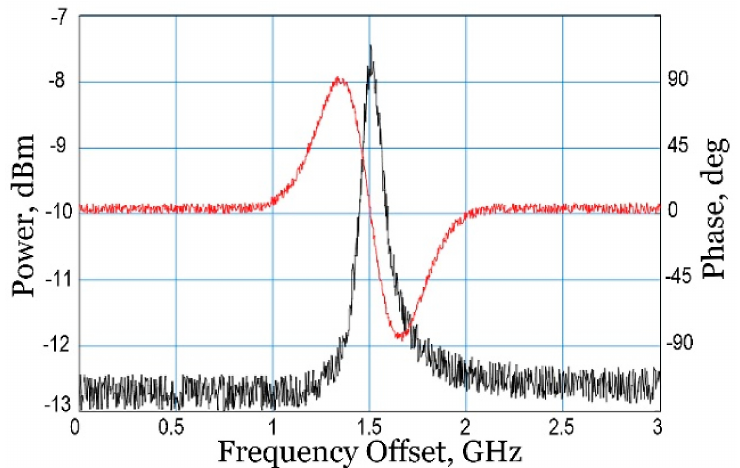
Figure 15. Fulfillment of the criterion for the signal to fall within the limits of the studied [35] © 2019 ITM Web of Conferences